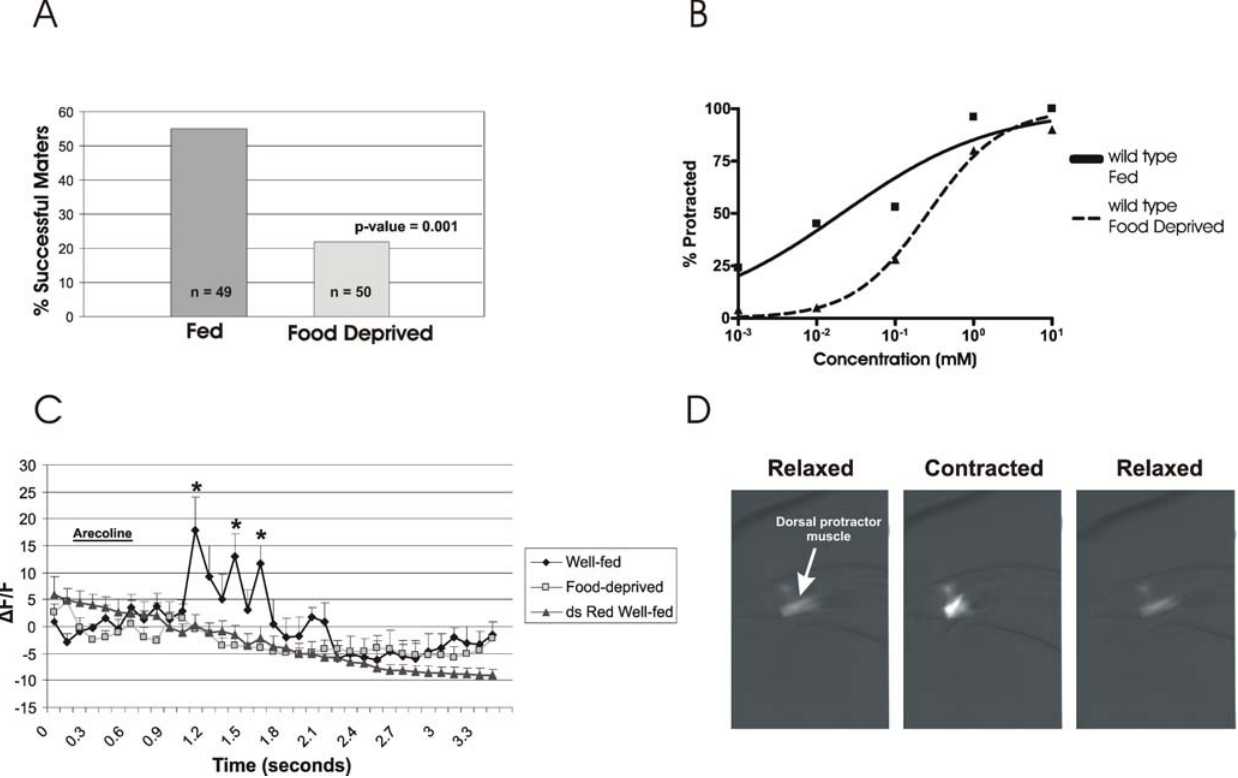
Figure 1. Effects of food deprivation on male sex-muscle excitability. (A) Mating success for fed and 15hr food-deprived males. Males were scored as successful if they sired at least 1 progeny. p-value determined by Fisher’s exact test (B) Graph of male muscle arecoline (ARE) sensitivity. For each concentration assayed, 20–30 males were assayed. (C) Mean sex-muscle G-CaMP responses to 10mM ARE for fed (n=4) and food-deprived (n=4) males. The * denotes well-fed time points that are significantly different (p # 0.05, Bonferroni posttest) then the food-deprived control. For fed males, the mean dsRed intensity trace is shown as a control. Error bars represent standard error of the mean. (D) Three representative frames displaying ARE-induced calcium changes in the sex muscles of a well-fed male (time between each frame is approximately 0.7 seconds). Anterior is to the right and the dorsal protractor muscles are labeled. Scale bar 6 m m.